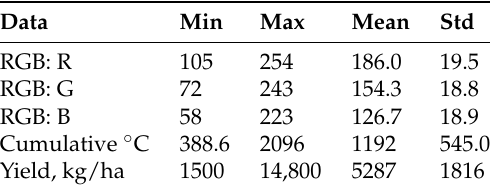
Table 2. The value ranges of used input and target variables prior